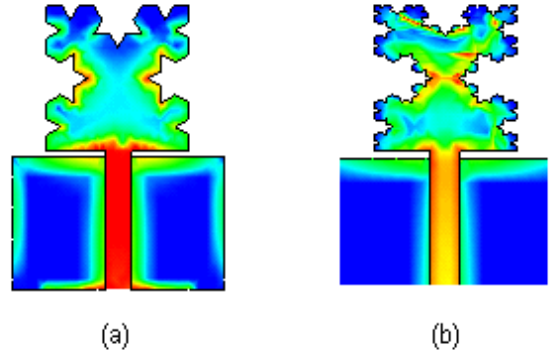
Figure 4: The surface current distributions on the 2nd and the 3rd iteration Koch fractal monopole antenna structures.